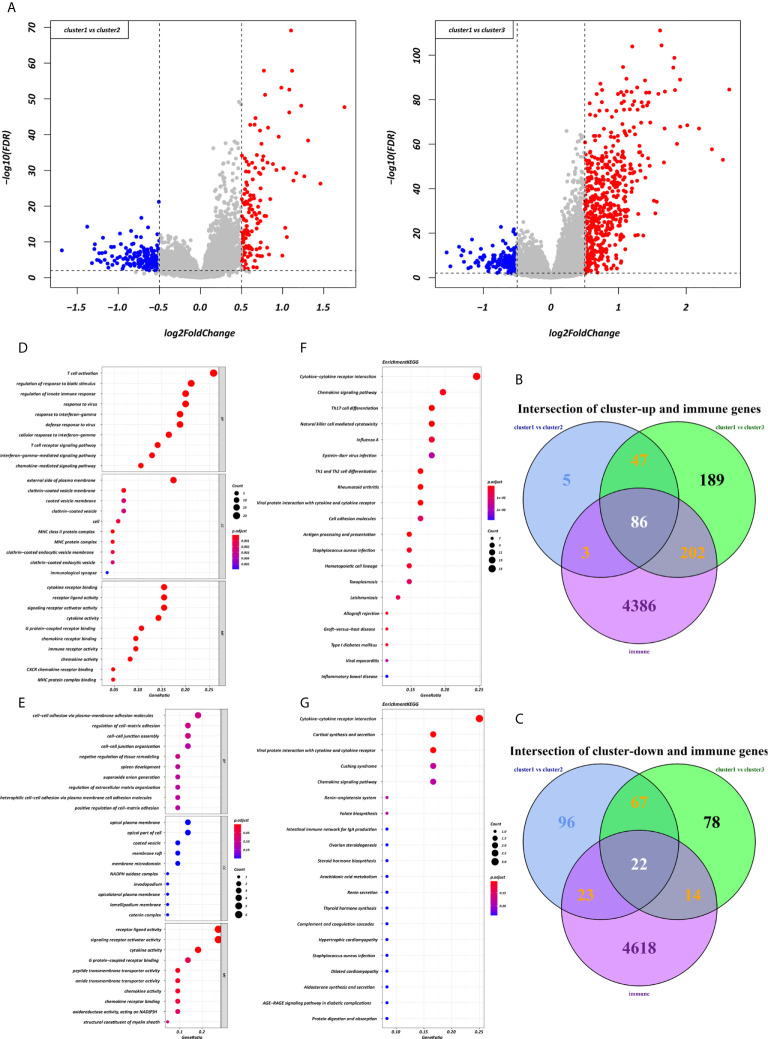
Expression and enrichment analyses of DEIRGs between the three clusters. (A) Volcano plot of DEGs. (B, C) Venn diagram of up- and downregulated DEIRGs. (D, E) Dot plot showing the top 10 most significant GO terms of up- and downregulated DEIRGs, including BP, CC, and MF. (F, G) The top 20 KEGG pathways of up- and downregulated DEIRGs that are shown in the dot plot.